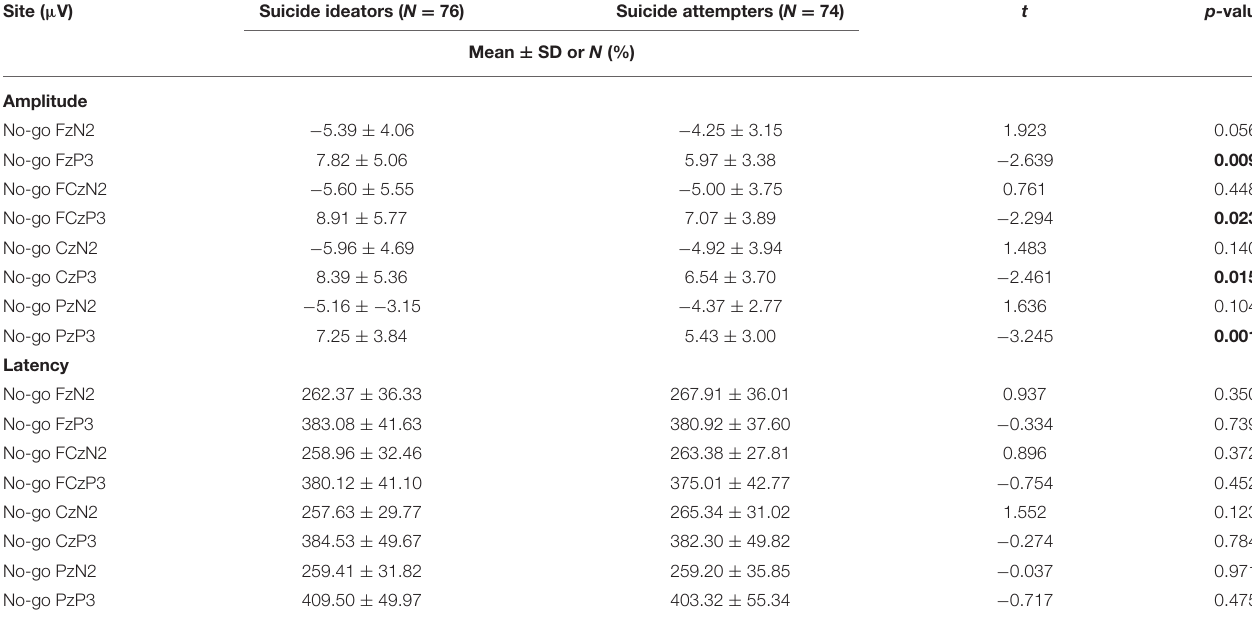
TABLE 3 | Comparison of the amplitude and latency of no-go N2, P3 between patients with suicide ideators and with suicide attempters. Site ( µ